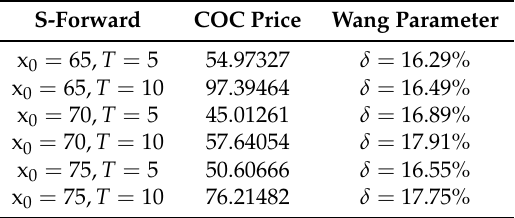
Table 11. Equivalent Wang parameters, CIR